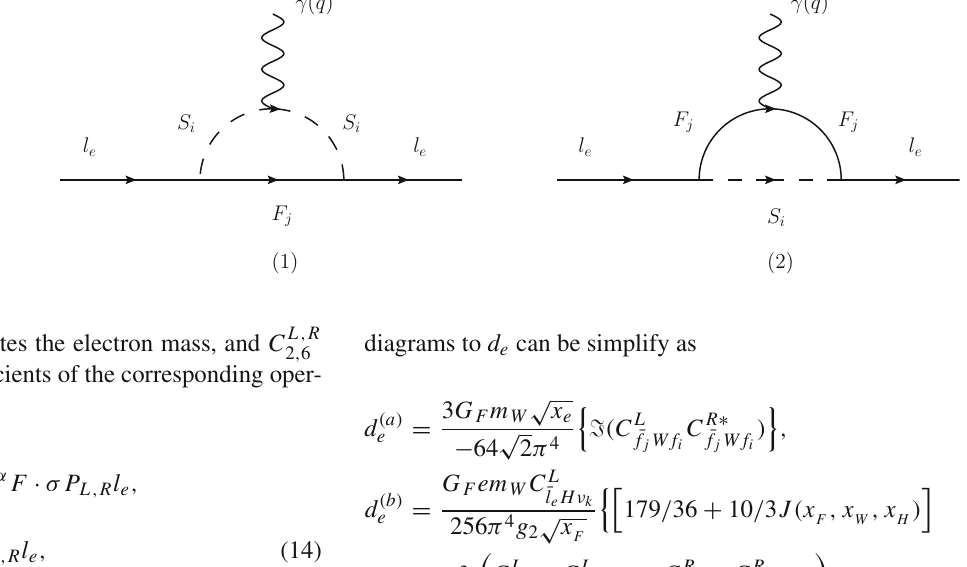
Fig. 1 The one-loop level diagrams contribute to the electron EDM, where a represents the charged scalars loops, and b represents the charged fermions